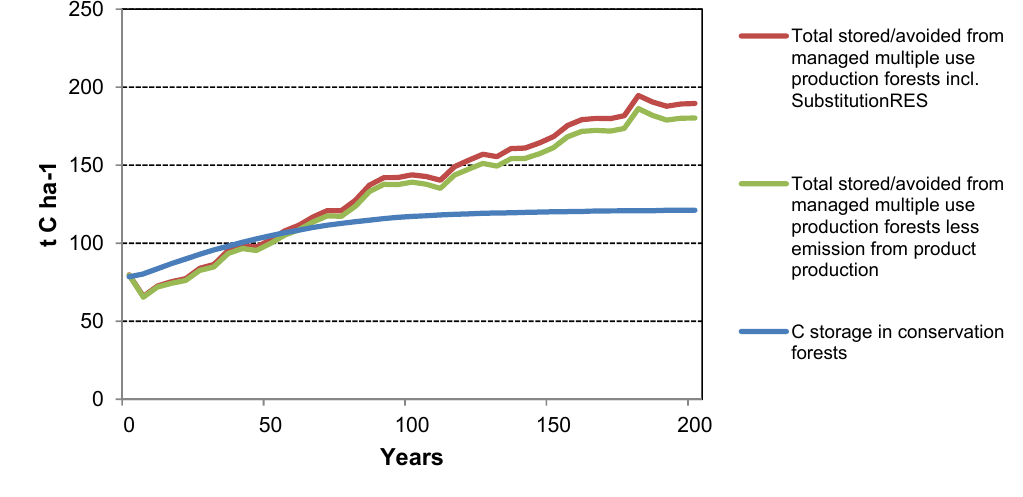
Figure 11. GHG implications of the “ production ” and “ conservation ” scenarios for SC forests (t C ha − 1 sequestered or displaced); total mitigation benefit includes Substitution and the net mitigation benefit discounting life cycle emissions over a 200 year